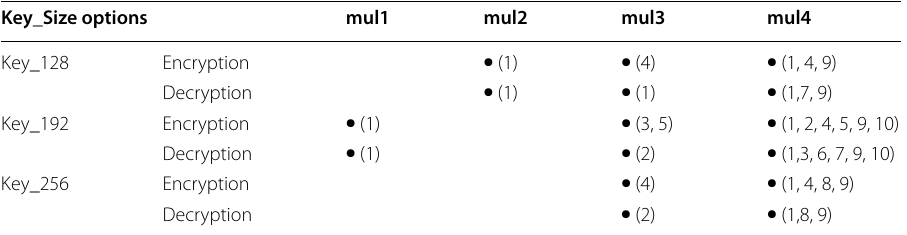
Table 2 Summary of reconfigurable control for